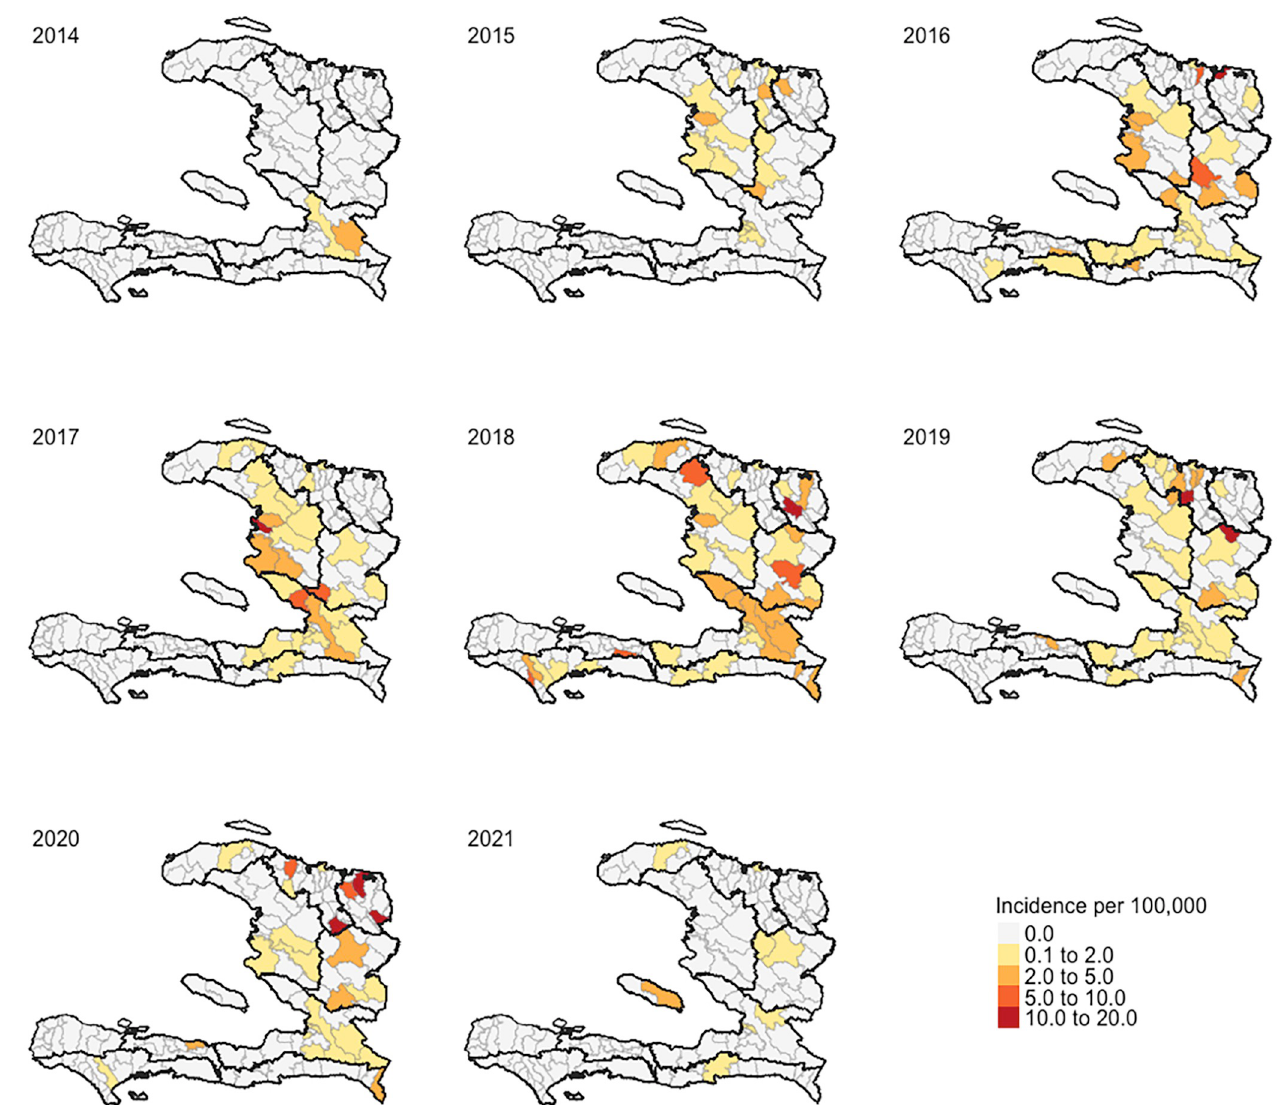
Fig 2. Diphtheria incidence (per 100,000) in Haiti, December 2014 –June 2021. of diphtheria cases per 100,000 by 0.030. The adjusted R 2 for the final OLS model was 0.15,